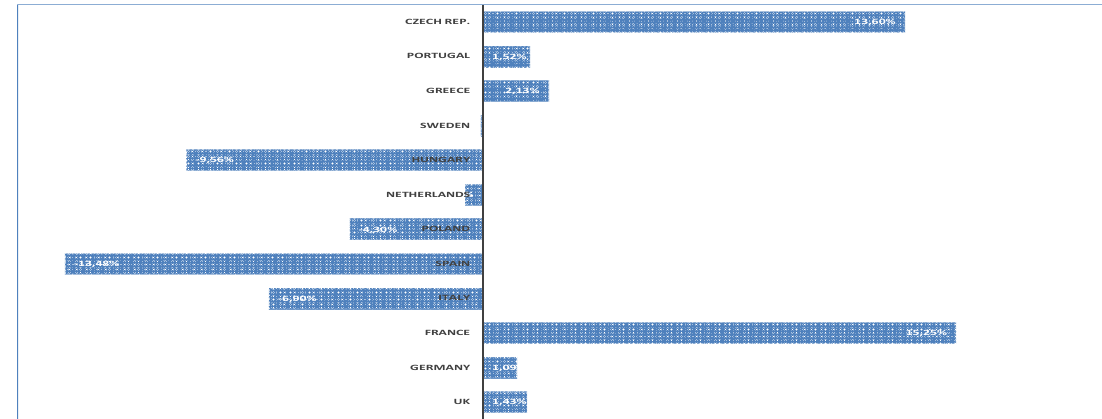
Graph 2: Evolution of Concentration by Countries (C-Standard Deviation of Workers amongst Areas), Per cent in 2011-